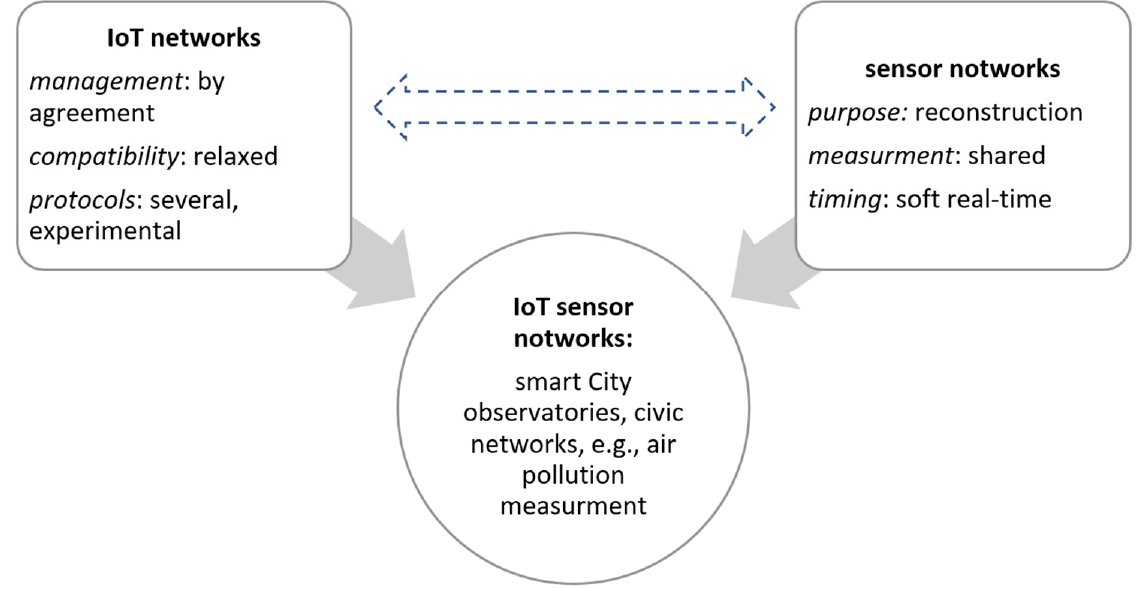
Figure 1. The main important elements of IoT sensor networks. Source: [4].